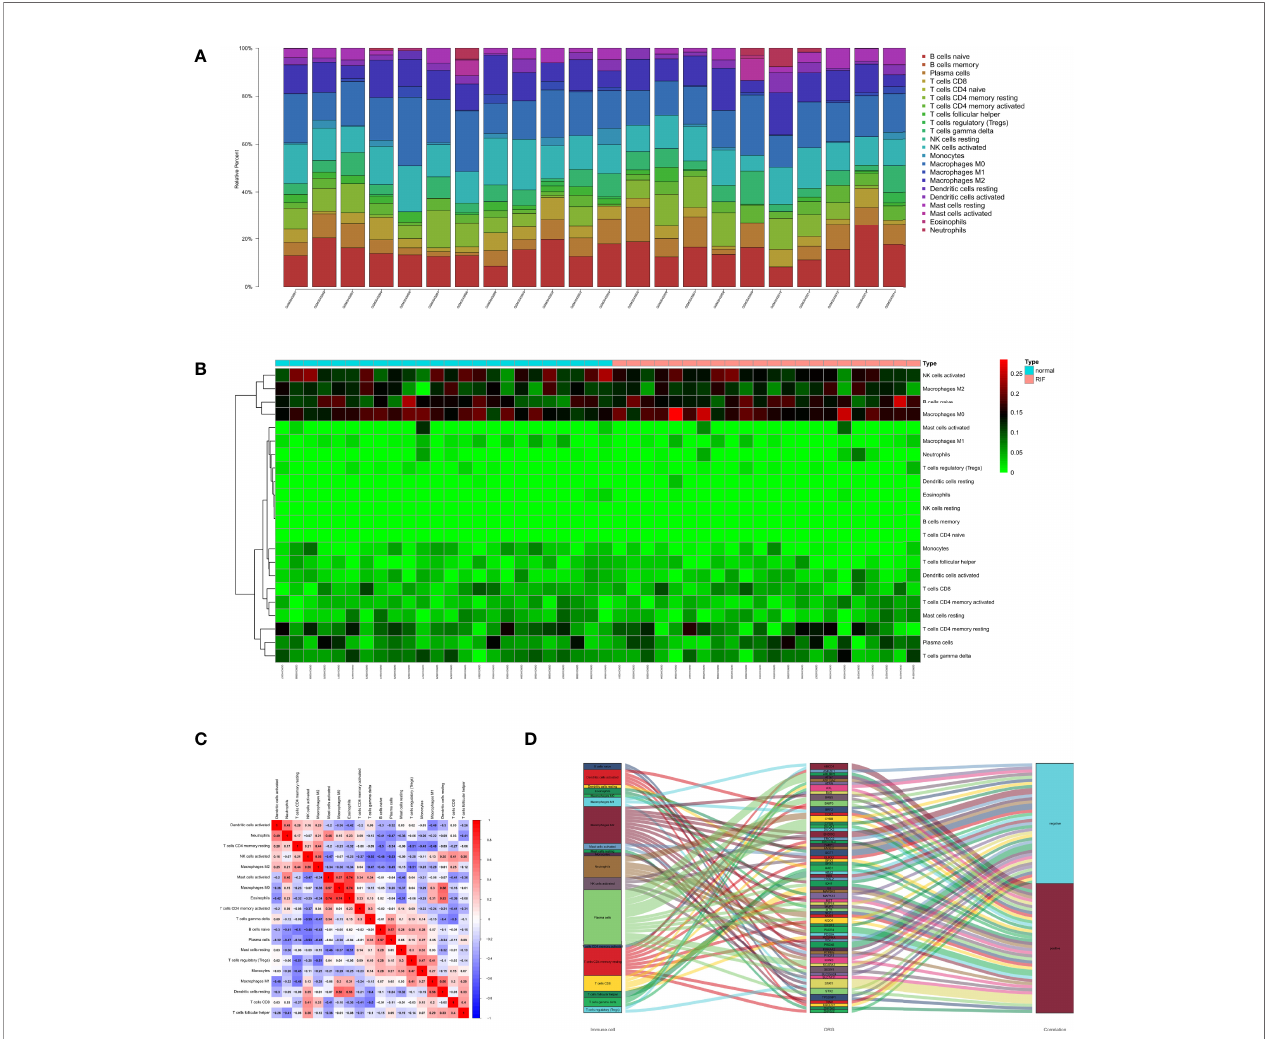
FIGURE 3 | Distribution of immune cells between normal and recurrent implantation failure sample using CIBERSORT for all eligible samples in the derivation cohort. (A) Barplot showed the fractions of immune cells in individual samples. (B) Heatmap showed normalized absolute abundance for each cell type in individual samples. (C) Correlation heatmap showed gene co-expression patterns among signi fi cantly altered immune cells. (D) Sankey diagram showed the relationships between the immune cells and their co-expressed